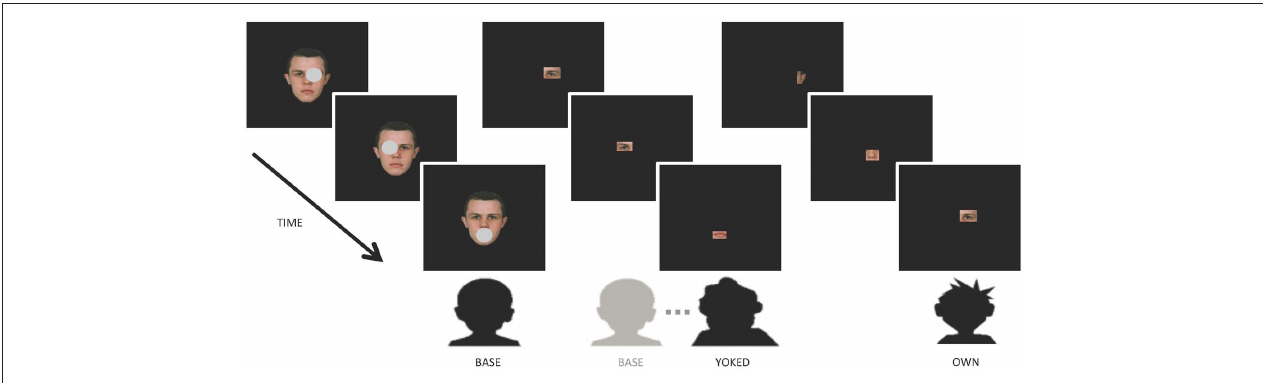
FiguRE 1 | Display sequence in the study block. Base participants freely viewed the face (fixations are represented by the gray circles); yoked participants were restricted in viewing to a moving window which replayed the